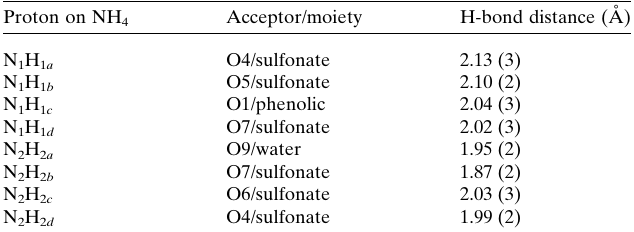
Table 3 Hydrogen-bond geometry (A˚ , (cid:5) ) for (NH 4 ) 2 (tiron) (cid:2) H 2 O. D —H (cid:2)(cid:2)(cid:2) A